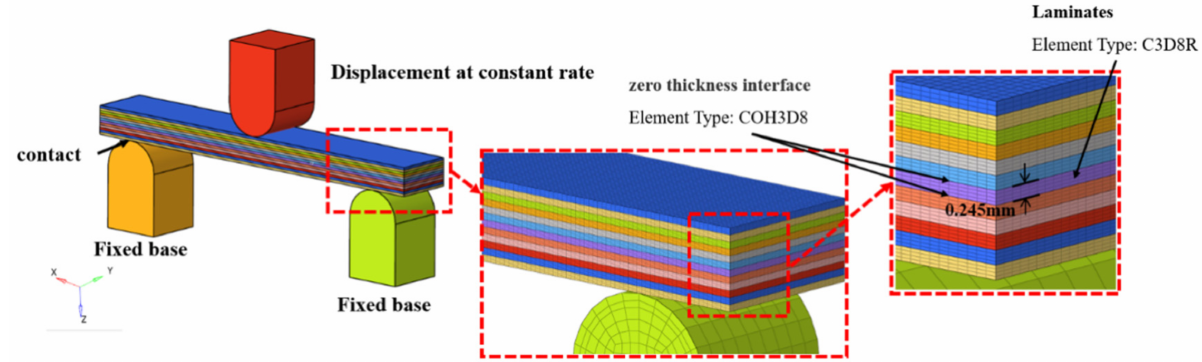
Figure 4. The 3D FE model of the 3-point bending test for 5-harness satin weave composite plates consisting of 12